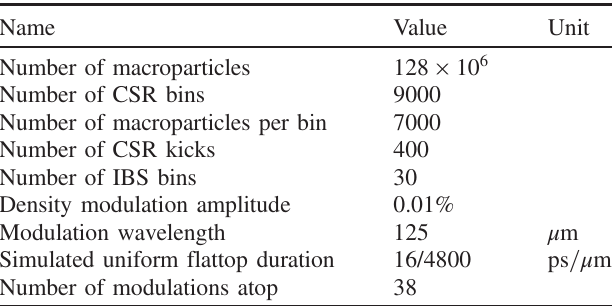
TABLE II. Numerical setting used in ELEGANT tracking sim-